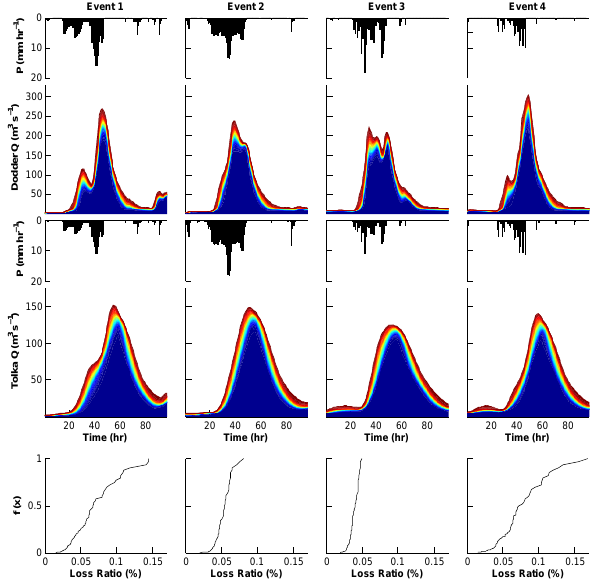
Figure 8. Plots showing event hyetographs and hydrographs for the River Dodder (rows 1 and 2) and River Tolka (rows 3 and 4), and cumulative distribution function plots of modelled losses across the entire domain (row 5). The number of parameter sets simulating discharge at or above a given level at time t is represented by the hydrograph colour, ranging from all 100 (dark blue) to 1 (dark red). The weighted 5th–95th-quantile values from these plots are shown in Table